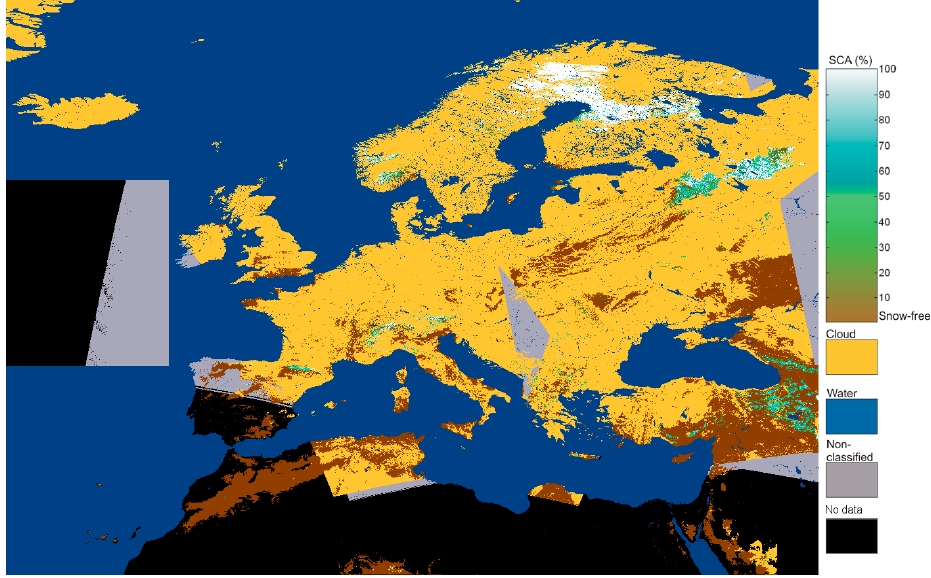
Figure 3. H-SAF H12 product quick-look image (25° W–45° E, 25°–75° N), 5 April 2017.